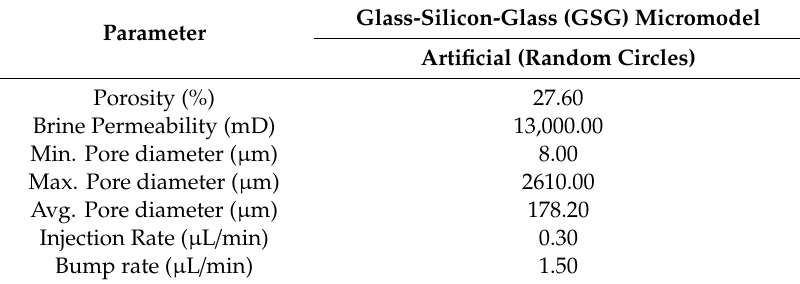
Table 2. Characteristics of micromodel and experiment used in this work.